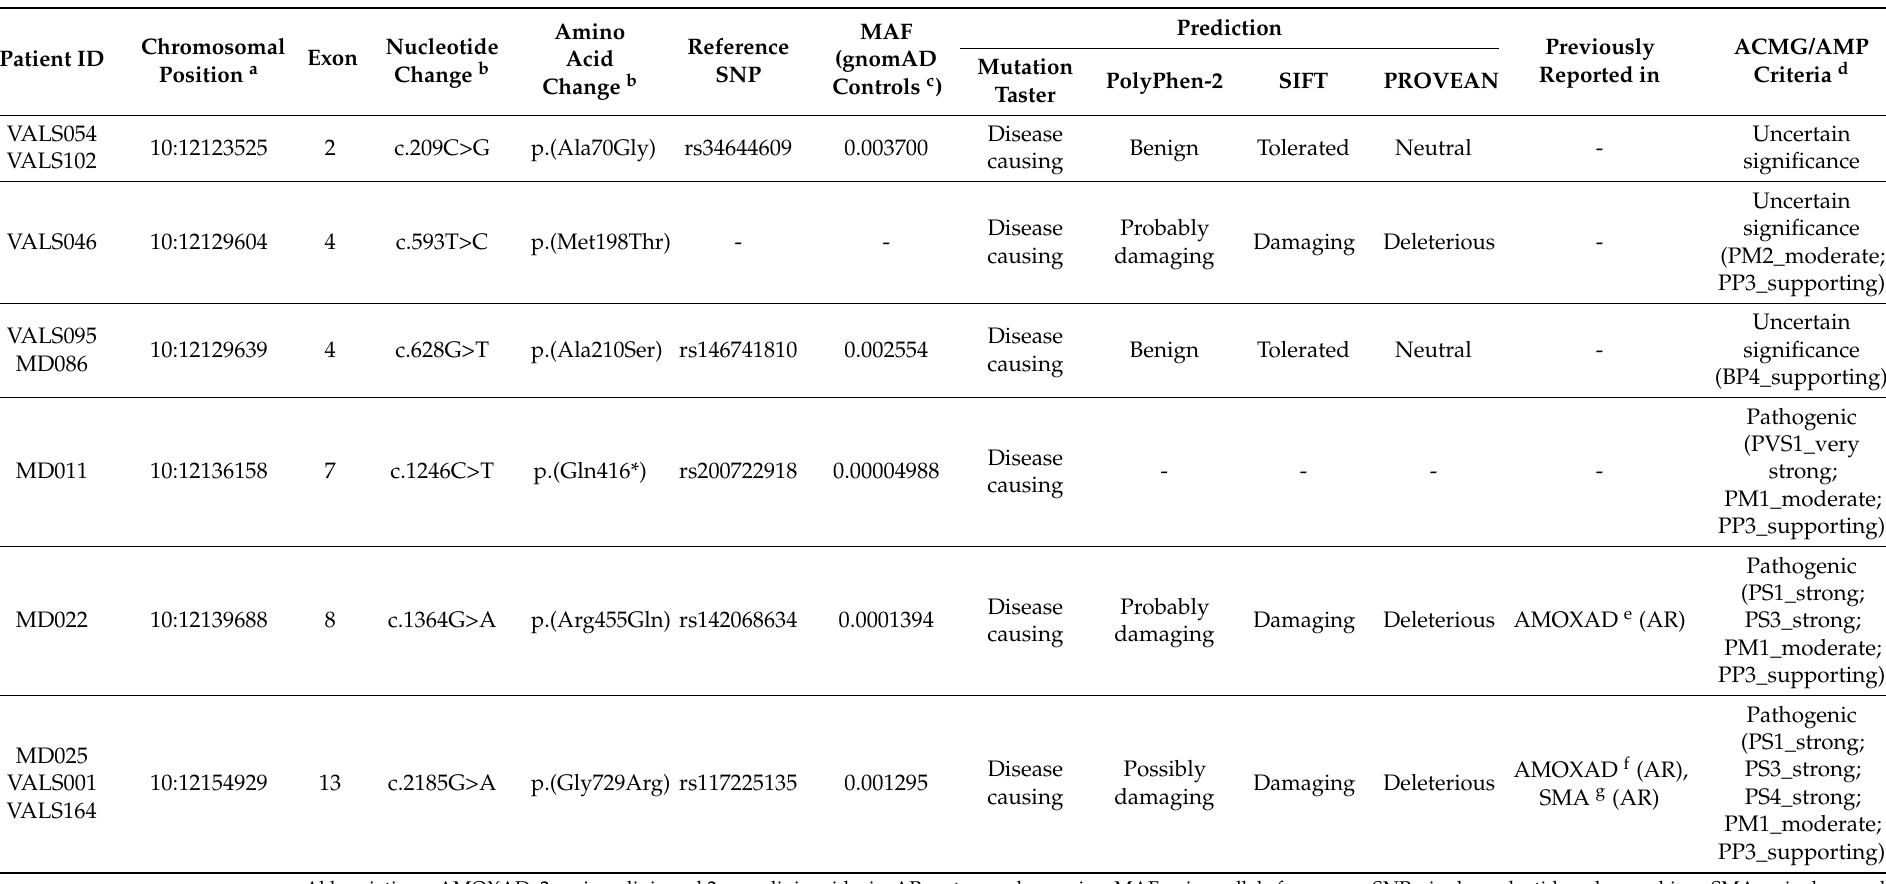
Table 1. Rare heterozygous non-silent DHTKD1 variants predicted to be deleterious identified in sporadic ALS patients of cohort 1 ( n = 225 ALS